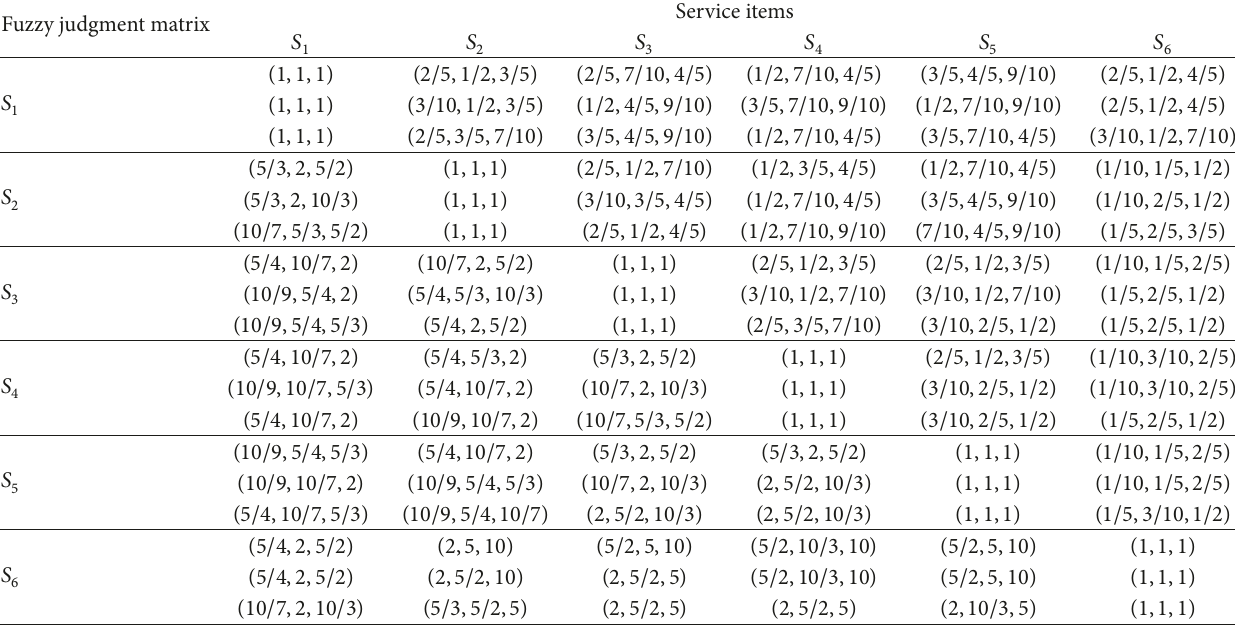
Table 2: Fuzzy judgment matrix of service